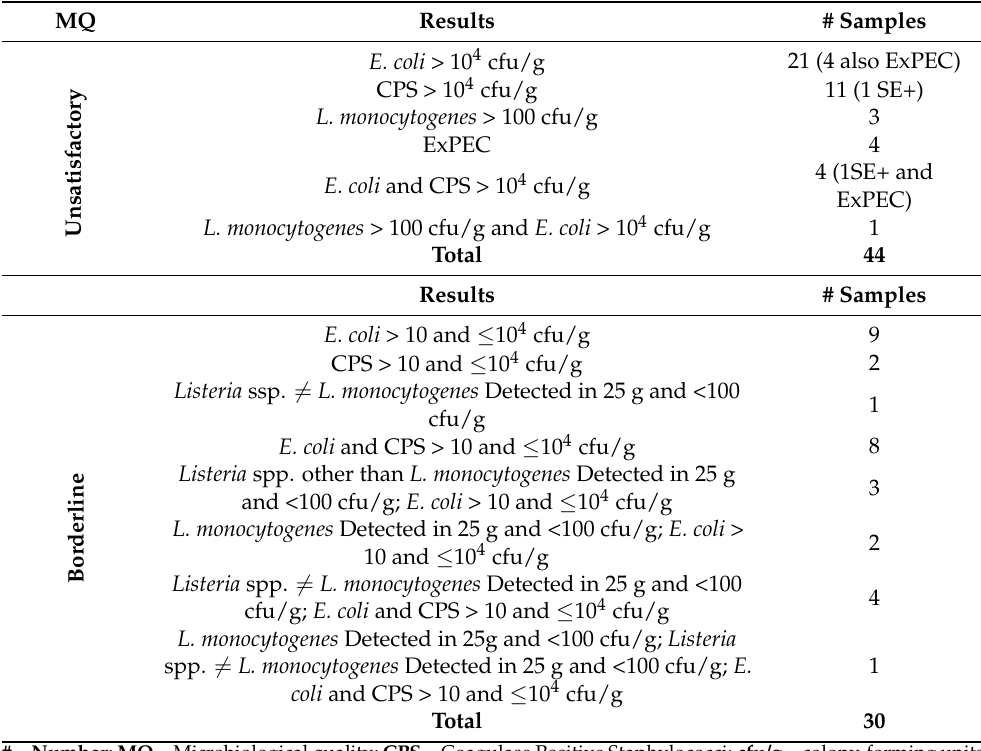
4 (1SE+ and ExPEC) 1 3 2 4 1